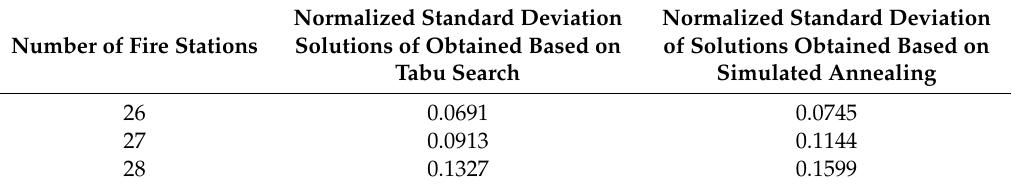
Table 9. The normalized standard deviation of solutions obtained using the VAOMP model with both algorithms.